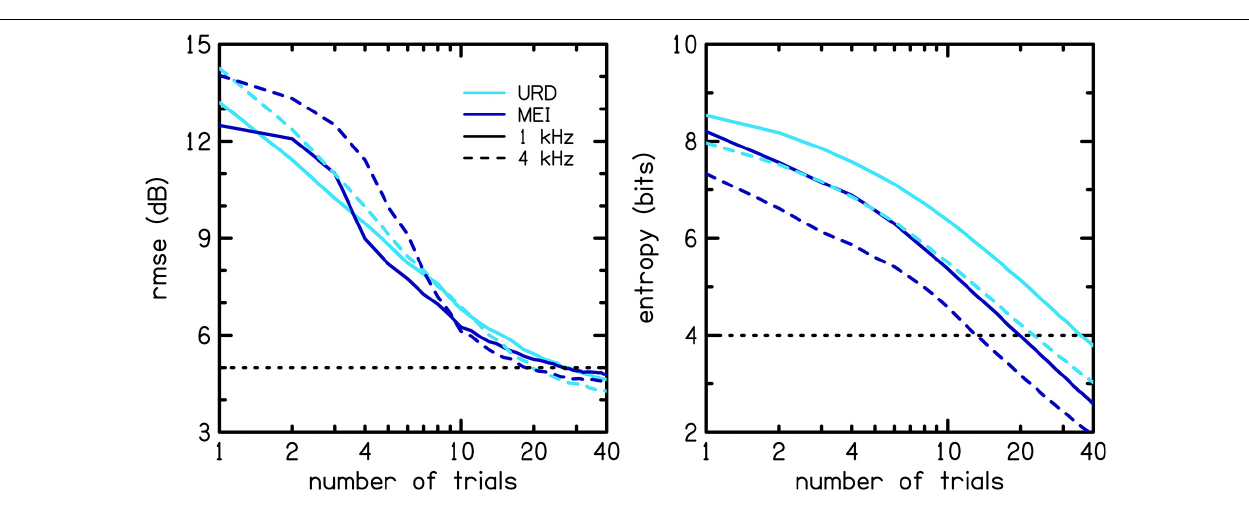
FIGURE 8 | Model simulation from a catalog created in previous work (Trevino et al., 2016a). Root-mean-square error (rmse; left panel) and entropy (right panel) for the MEI algorithm (dark blue lines) are compared to those for the Uniform Random Distribution (URD; light blue lines) procedure. The solid lines represent 1 kHz and the dashed lines represent 4